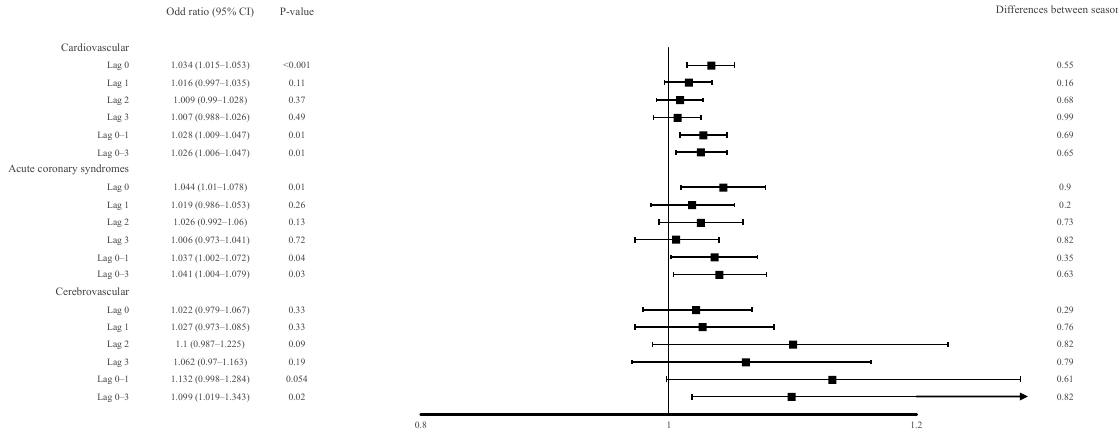
Figure 3. Meta-analysis results for the associations between the exposure to short-term particulate matter with a diameter of 10 µ m or less and cardiovascular-, acute coronary syndrome-, and cerebrovascular-related mortality.